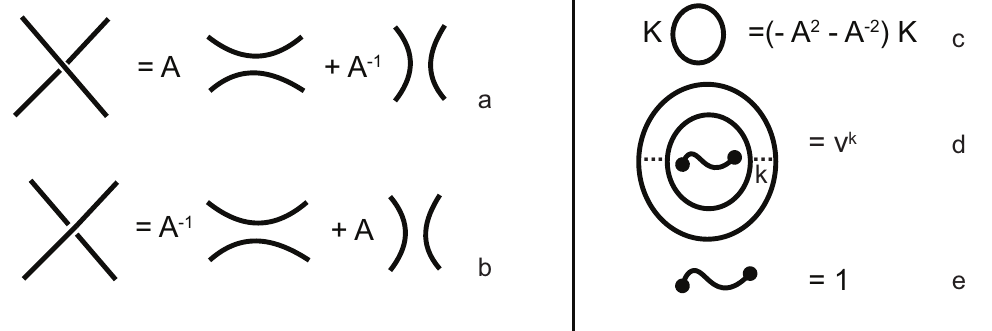
Figure 10. The Turaev loop bracket rules. ( a , b ) The smoothing rules; ( c ) the loop value; ( d ) the value for nested loops enclosing a long segment; ( e ) the long segment value.